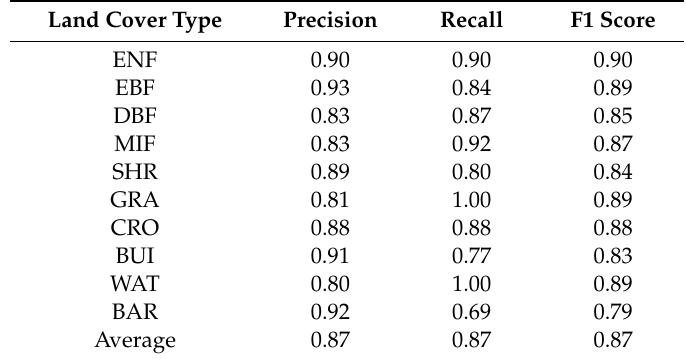
Table 3. Performance of SST-based random forest (RF) classifier.